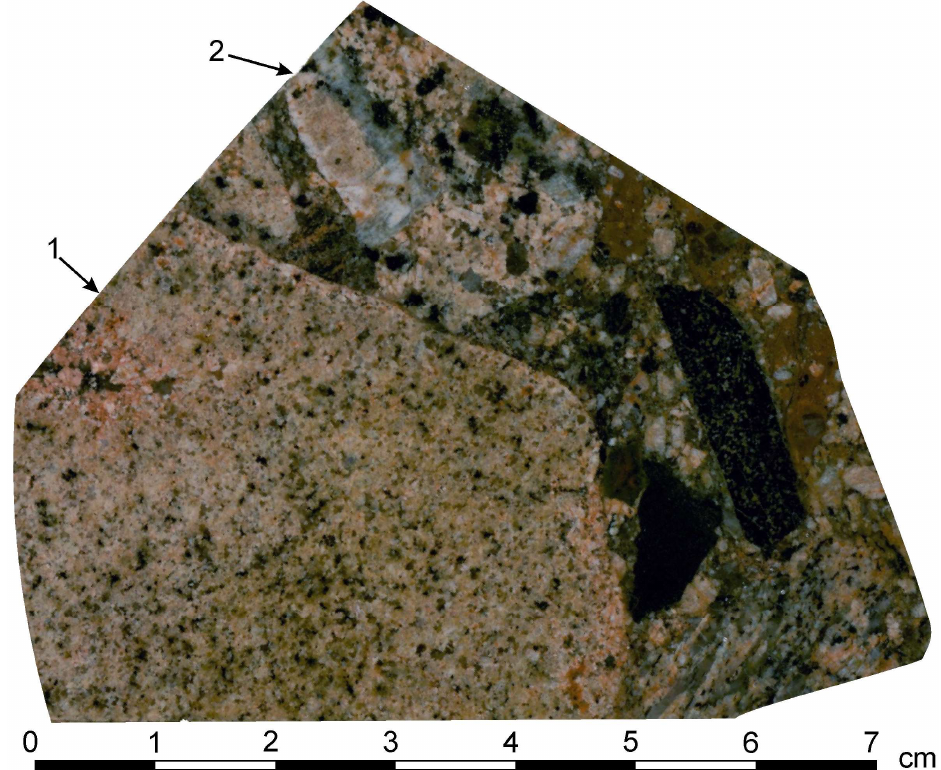
Figure 5. Polished cut of breccia with granite porphyry cement. The numbers indicate the following: 1—xenolith of fine-grained biotite granite (similar samples X#1 and X#2), 2—xenolith of biotite-amphibole granite with a characteristic “rapakivi”—K-feldspar ovoid in an oligoclase rim.